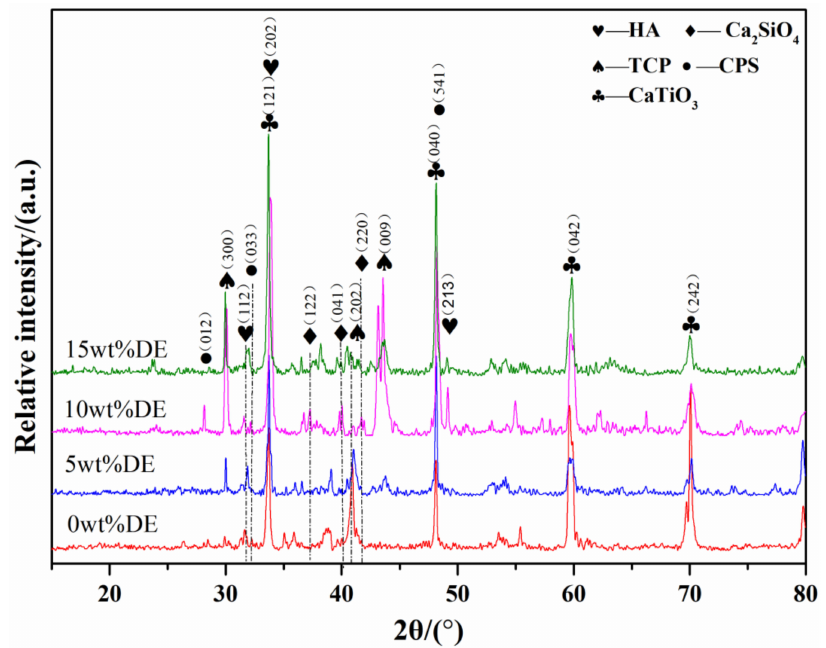
Figure 2. XRD patterns of bioceramic coating with different contents of DE (0wt%, 5wt%, 10wt% and